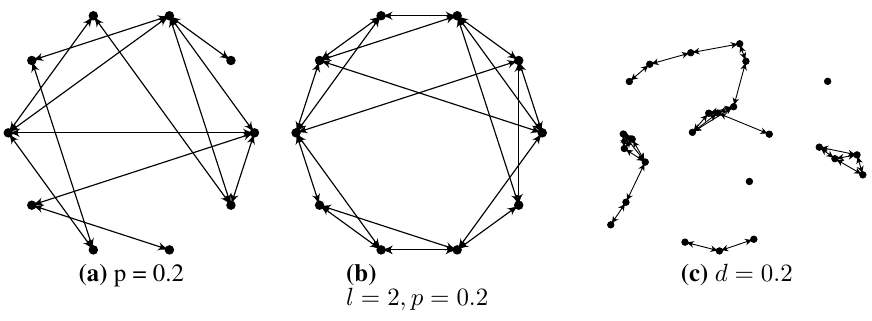
Figure 2. Random network